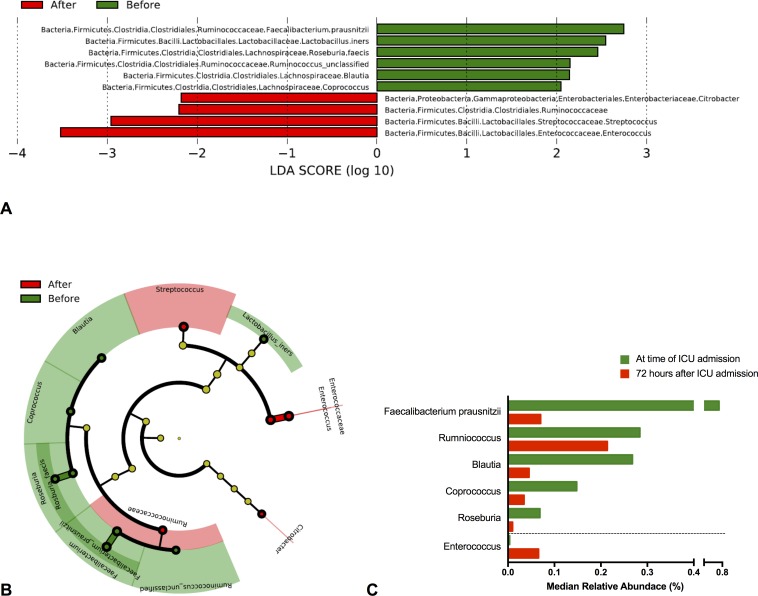
Changes within specific bacterial taxa, comparing ICU admission and 72 hours later.Using a linear discriminant analysis (LDA)-based algorithm, significant declines were identified in the short chain fatty acid-producing Clostridial Clusters IV (Faecalibacterium prausnitzii) and XIVa (Blautia, Coprococcus, Roseburia, and Ruminococcus) with an expansion in Enterococcus. Changes within specific bacterial taxa are shown as (A) LDA scores, which are proportional to the relative change within each of the bacterial taxa shown, (B) a cladogram, which shows the hierarchical relationship of these different taxa in relationship each other, and (C) relative abundance of these taxa. For (C) only taxa with a pooled minimum of 0.05% median relative abundance are depicted.